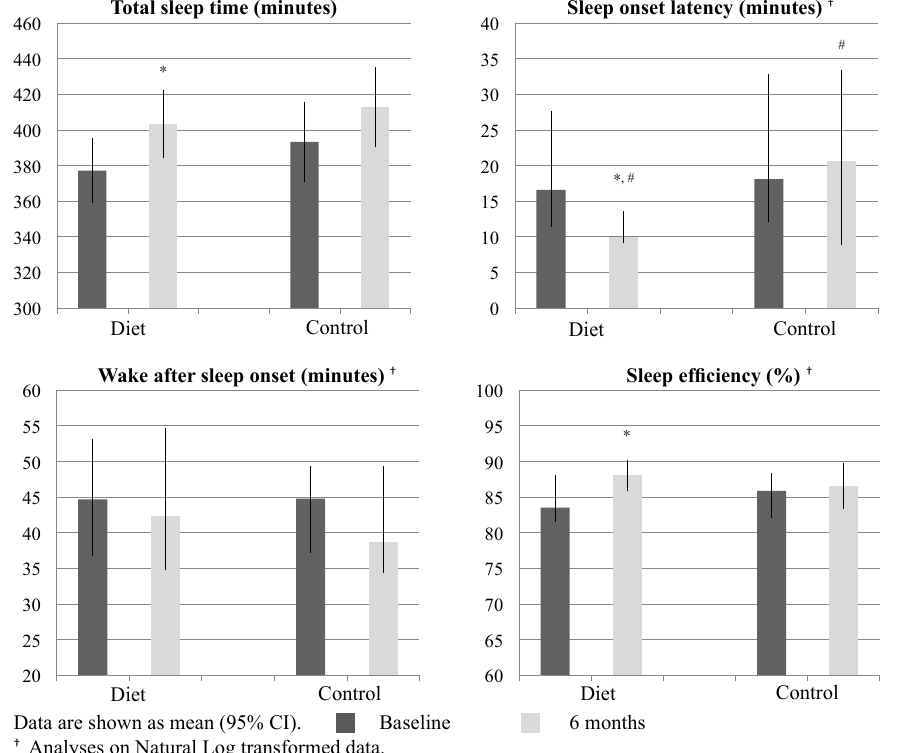
Figure 3. Sleep outcomes by piezoelectric system at baseline and six months.